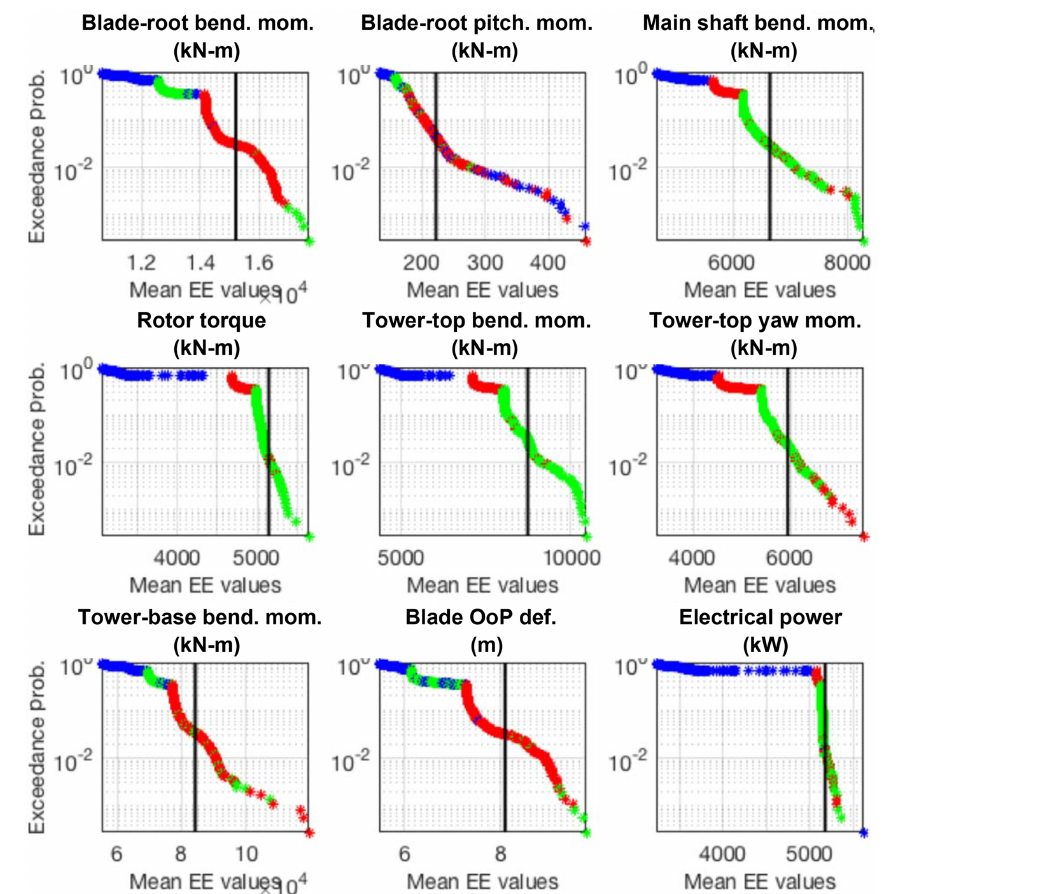
Figure B3. EE-value exceedance probability plots of ultimate loads for aeroelastic turbine parameters, across all wind speed bins, input parameters, and simulations points for all QoIs. The black line represents the defined threshold by which outliers are counted for each QoI. Color indicates wind speed bin (blue is below-rated speed, red is near-rated speed, green is above-rated